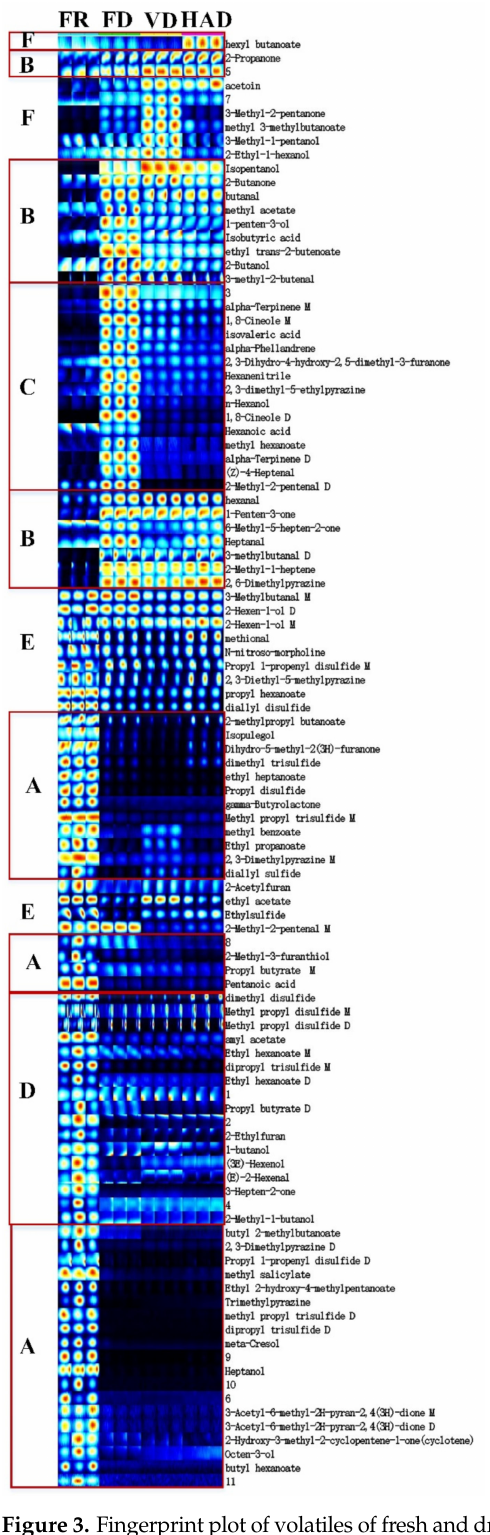
Figure 3. Fingerprint plot of volatiles of fresh and dried AMR treated by using different drying methods. 2-Propanone, isopentanol, 2-butanone, butanal, methyl acetate, 1-penten-3-ol, isobu- tyric acid, ethyl trans-2-butenoate, 2-butanol, 3-methyl-2-butenal, hexanal, 1-penten-3-one, heptanal, 6-methyl-5-hepten-2-one, 3-methyl butanal D, 2-methyl-1-heptene, and 2,6-dimethyl pyrazine, labelled as B, were not detected in fresh AMR samples, but exist in dried AMR samples, so there were generated during drying. Alpha-terpinene M, 1,8-cineole M,